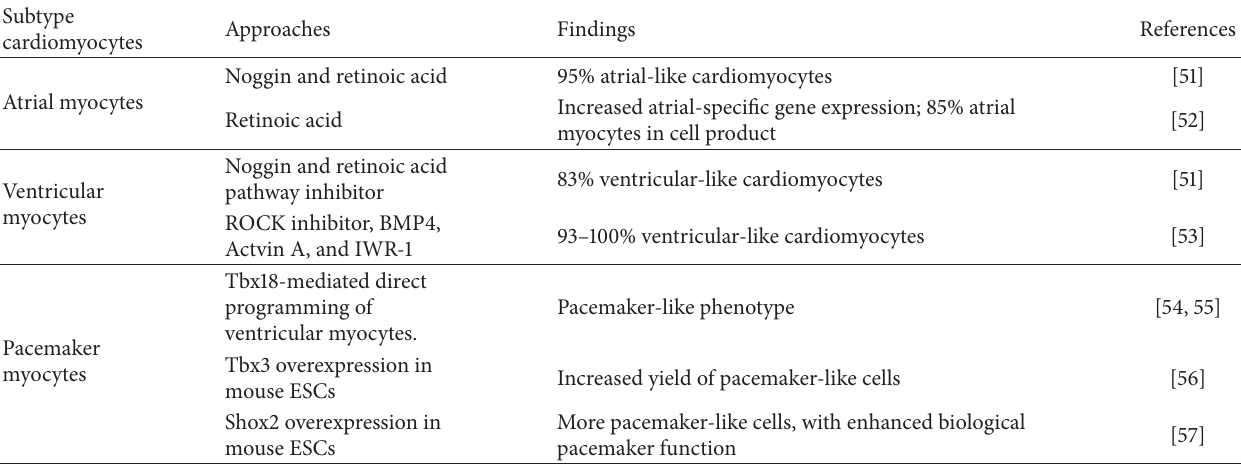
Table 2: Strategies for cardiac subtype myocytes